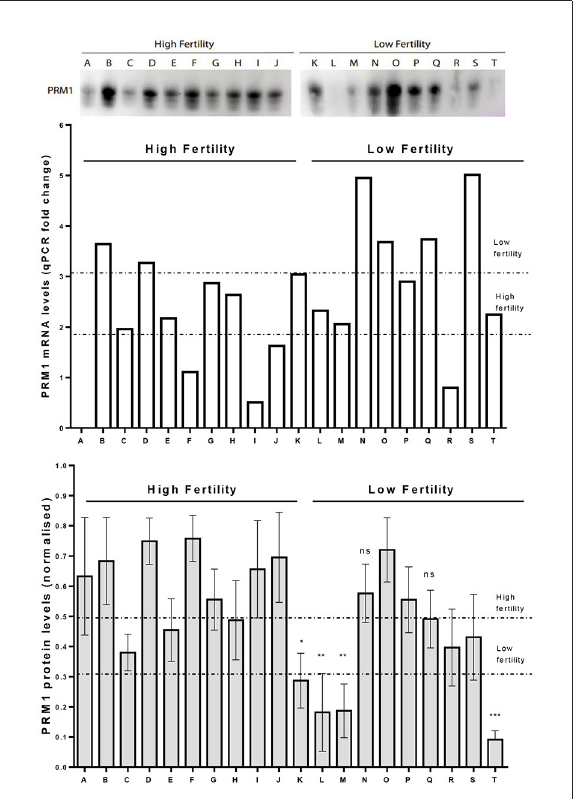
FIGURE5 Comparison on PRM1 transcription and protein abundance levels. Upper panel. A representative image for PRM1 protein levels assessed by Western Blot. Mid panel. PRM1 mRNA levels as revealed by qPCR where bull A was a control comparison. Lower panel. PRM1 protein levels assessed by Western Blot. Low fertility (LF) bulls presented on average, a decrease in the PRM1 protein abundance compared to high fertility (HF) bulls ( p < 0.05, unpaired t -test). The decrease in abundance was particularly evident in 4 LF bulls (K, L, M and T), while the others were similar to HF bulls. * P < 0.05; ** P < 0.01; *** P < 0.001; ns,